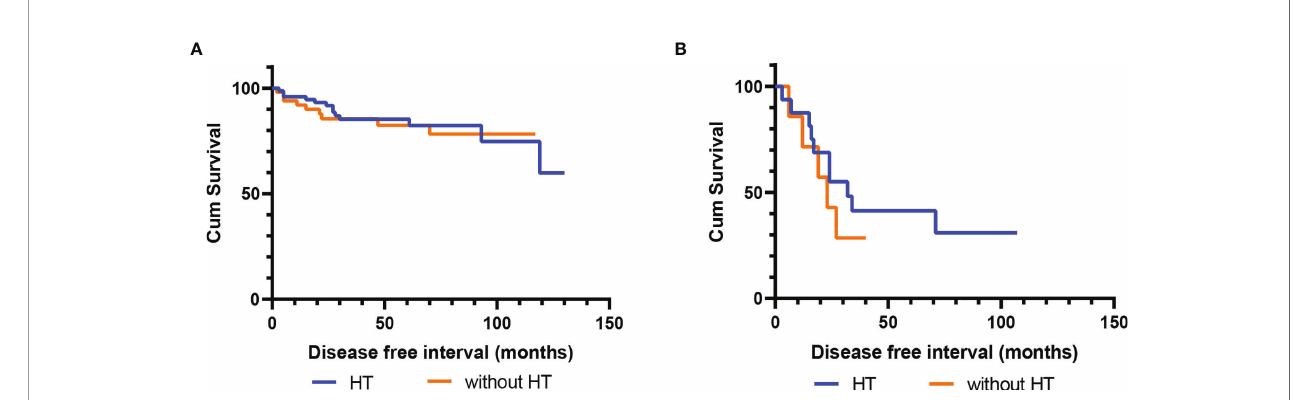
FIGURE 1 | Disease-free survival (DFS) of patients with and without postoperative hormone therapy. (A) The cohort without fertility-sparing (p=0.802); (B) The fertility-sparing cohort (p=0.466).